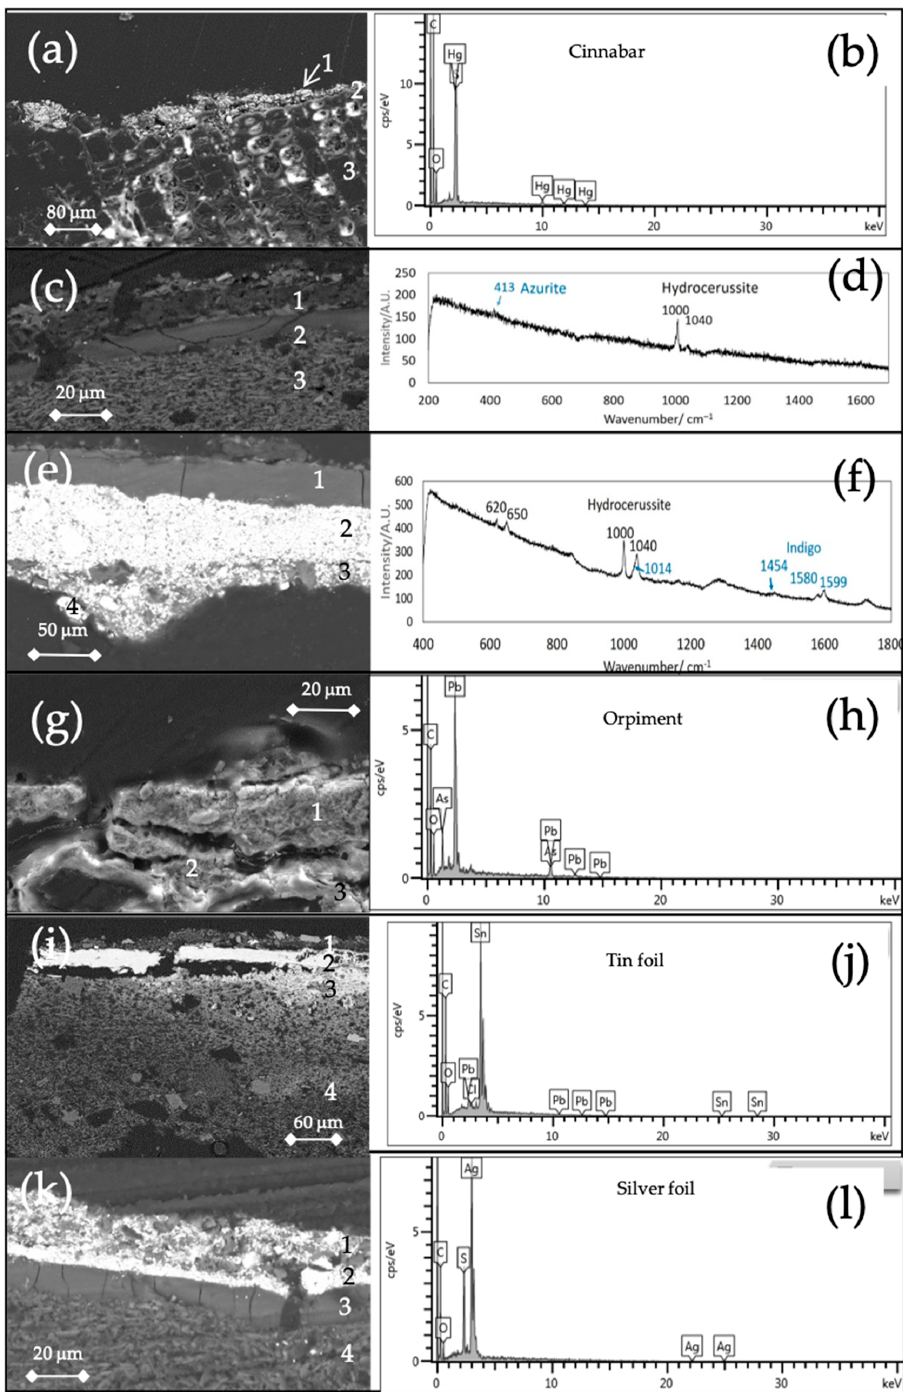
Figure 4. Backscattered electron images (BKS) of the cross-sections, X-ray, IR, and Raman spectra of the pigments identified: ( a ) BKS image of sample C-5; ( b ) X-ray spectrum of cinnabar (layer 2, in sample C-5); ( c ) BKS image of sample K-4; ( d ) Raman spectrum of azurite and lead white using laser source of 532 nm (layer 1 in sample K-4); ( e ) BKS image of sample F-1; ( f ) Raman spectrum of indigo and lead white using laser source of 532 nm (layer 3 in F-1); ( g ) BKS image of sample D-1; ( h ) X-ray spectrum of orpiment (layer 1 in sample D-1); ( i ) BKS image of sample J-2; ( j ) X-ray spectrum of tin foil (layer 2 in sample J-2); ( k ) BKS image of sample J-4; ( l ) X-ray spectrum of silver foil (layer 2 in sample